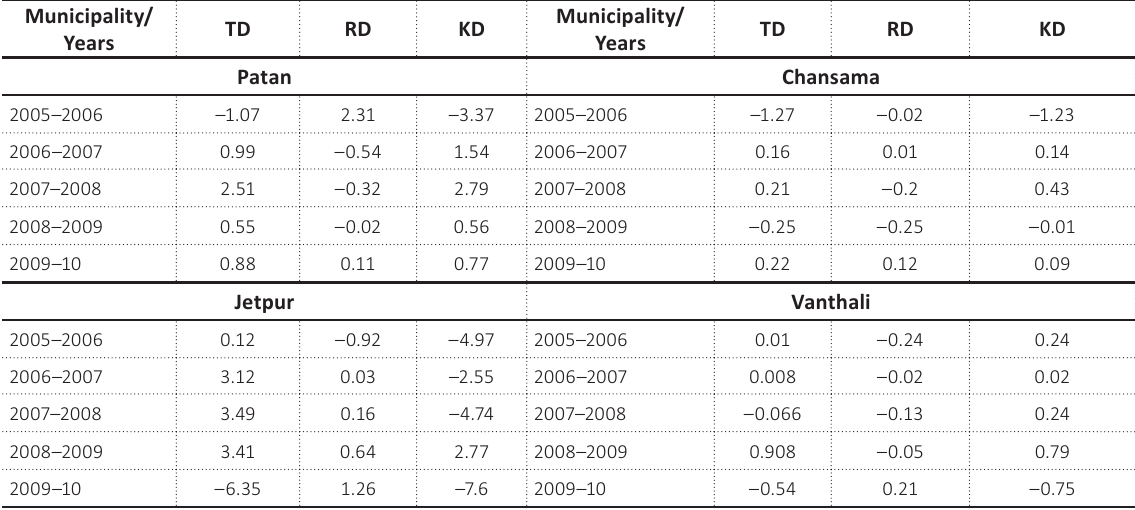
Source: Calculated from income and expenditure of various municipal budgets.